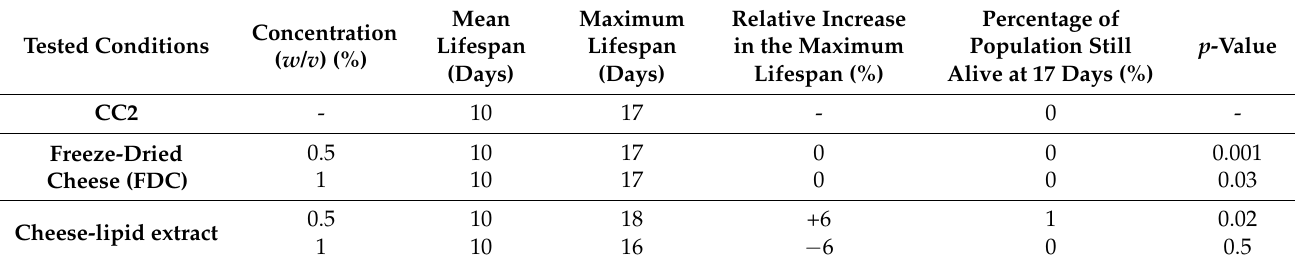
Figure 2. Influence of the FDC (freeze-dried cheese) ( A ) and the cheese-lipid extract ( B ) on the lifespan of C. elegans GR1307 strain. The worms were incubated on the medium supplemented with the dried extracts at day 0 and regularly fed with HK E. coli OP50. The conditions were considered significantly different when the p -value was lower than 0.05 (*) or 0.01 (**) (log-rank test). The asterisks next to the curves represent the differences with the control condition CC2. The asterisks next to the legend represent the differences between the extracts. Table 3. Data of the longevity assay of the C. elegans GR1307 strain on the medium supplemented with the FDC (freezz-dried cheese) and the cheese-lipid extract, and CC2 as control. Mean lifespan, maximum lifespan and the percentage of population still alive were taken from the survival curves in Figure 2. p -values were calculated by comparing conditions with CC2 using the log-rank test.